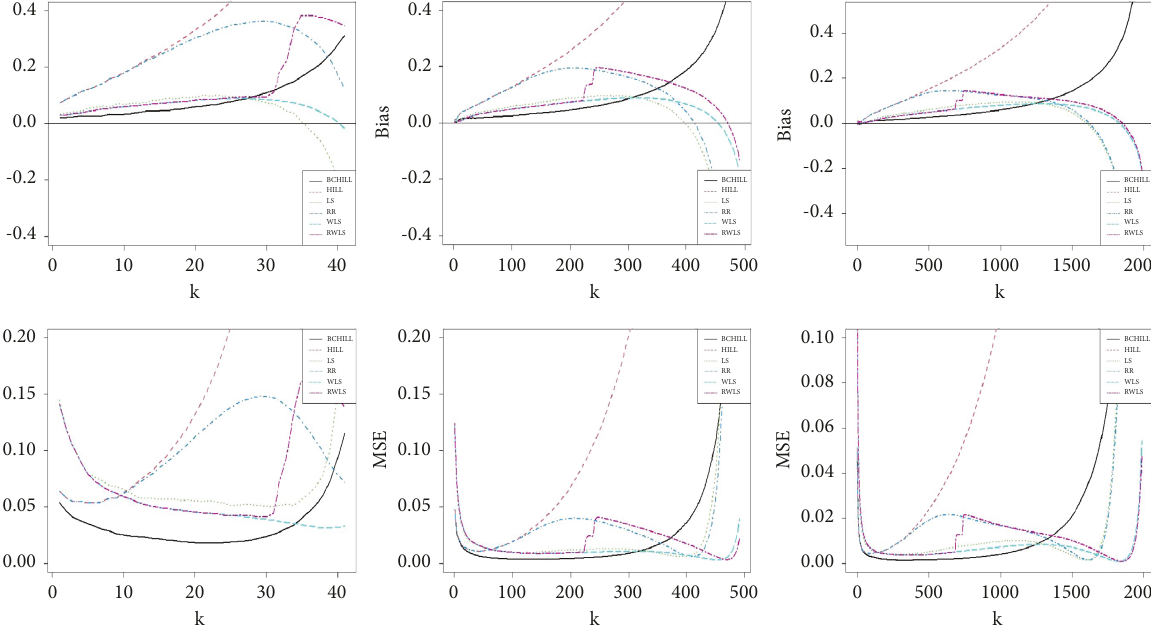
Figure 2: Results for Burr type XII distribution with c � 0 . 5: Bias (top row) and MSE (bottom row). First column: n � 50; second column: n � 500; and third column: n �